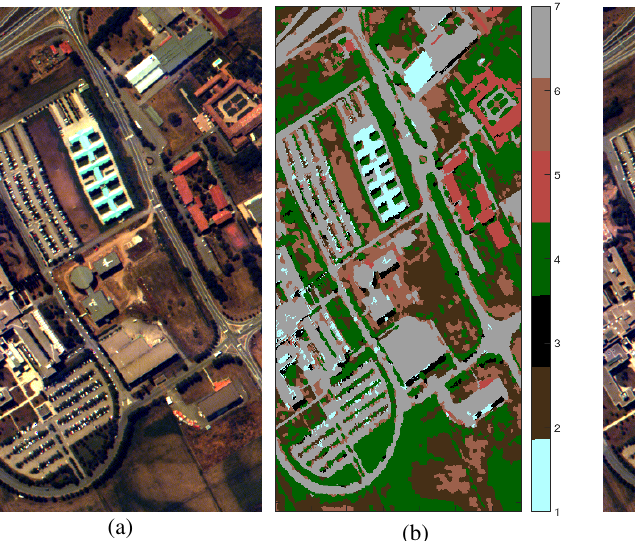
Figure 10. Preliminary labeled image for Pavia University after hierarchical tree partition.